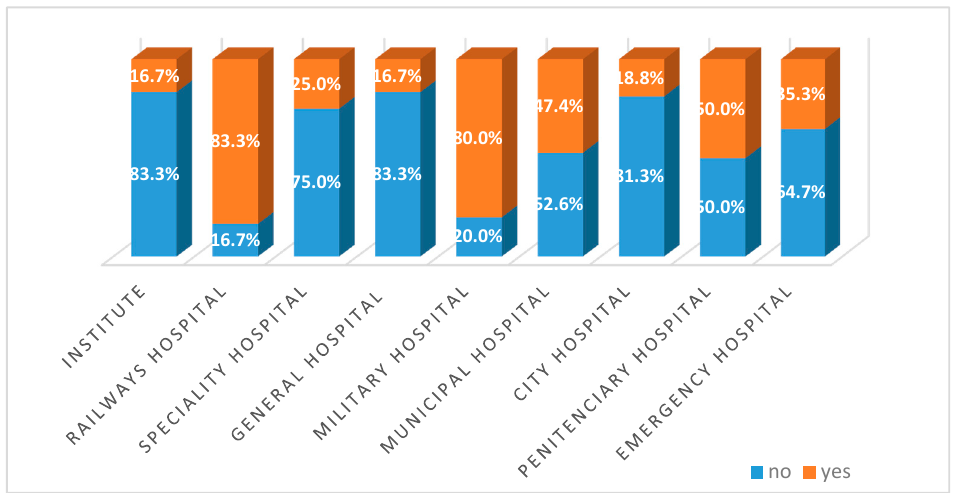
Figure 2. The prevalence of medicinal oxygen of purity 93% ± 3% by specialization.